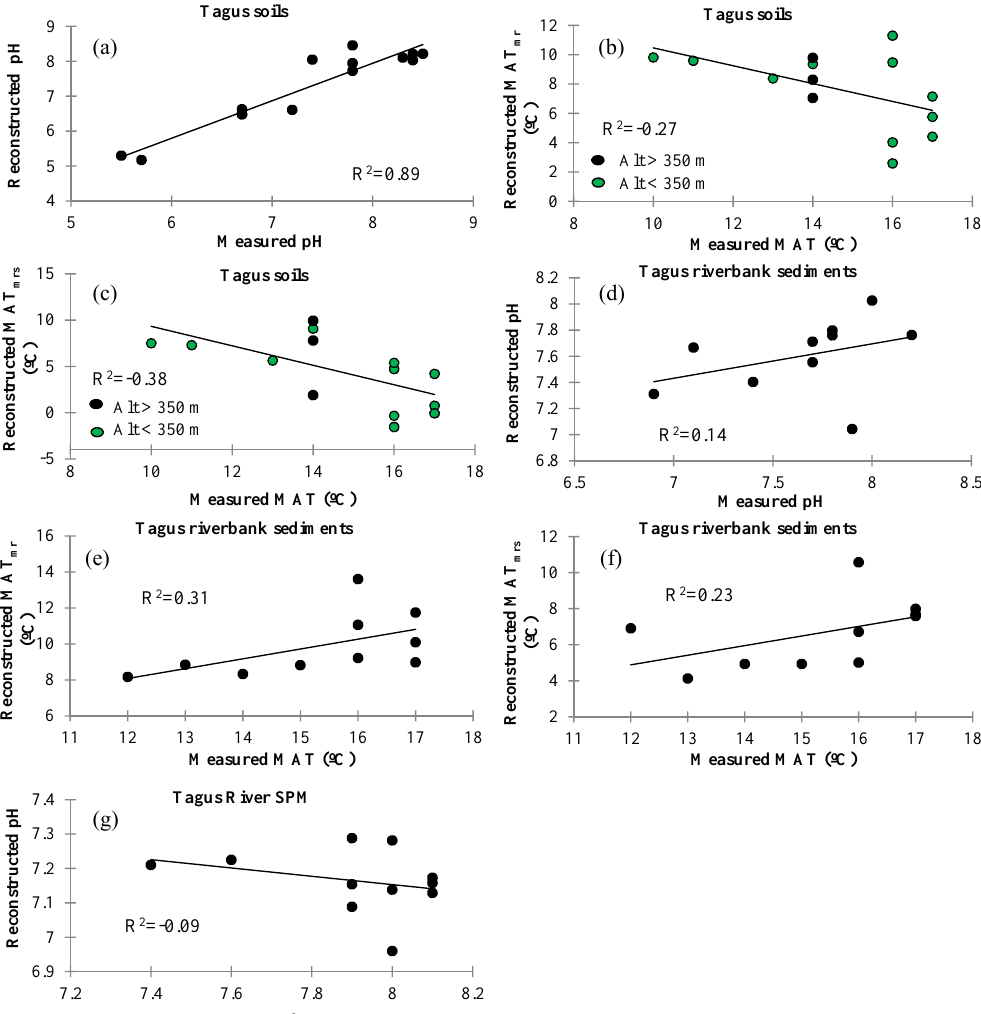
Figure 8. Panels (a) – (c) show scatterplots of the Tagus soil samples for (a) reconstructed and measured pH ( R 2 = 0.89), (b) reconstructed MAT mr ( ◦ C) and measured MAT ( ◦ C; R 2 = 0.27), and (c) reconstructed MAT mrs ( ◦ C) and measured MAT ( ◦ C; R 2 = 0.38). For panels (b) – (c) the soil samples from an altitude greater than 350m are indicated in black and those from an altitude below 350m are indicated in green. Panels (d) – (f) show scatterplots of the Tagus riverbank sediments for (d) reconstructed and measured pH ( R 2 = 0.14), (e) reconstructed MAT mr ( ◦ C) and measured MAT ( ◦ C; R 2 = 0.31), and (f) reconstructed MAT mrs ( ◦ C) and measured MAT ( ◦ C; R 2 = 0.23). Panel (g) is a scatterplot showing the reconstructed and measured pH for the Tagus River SPM samples ( R 2 =